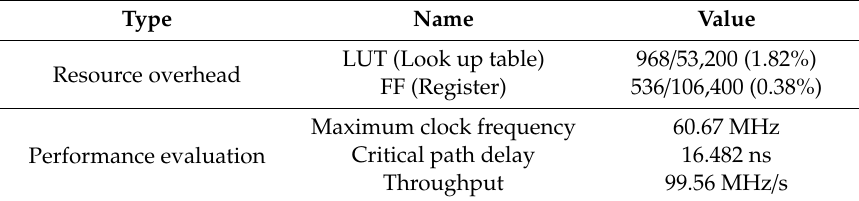
Table 4. Resource overhead and performance evaluation on FPGA.